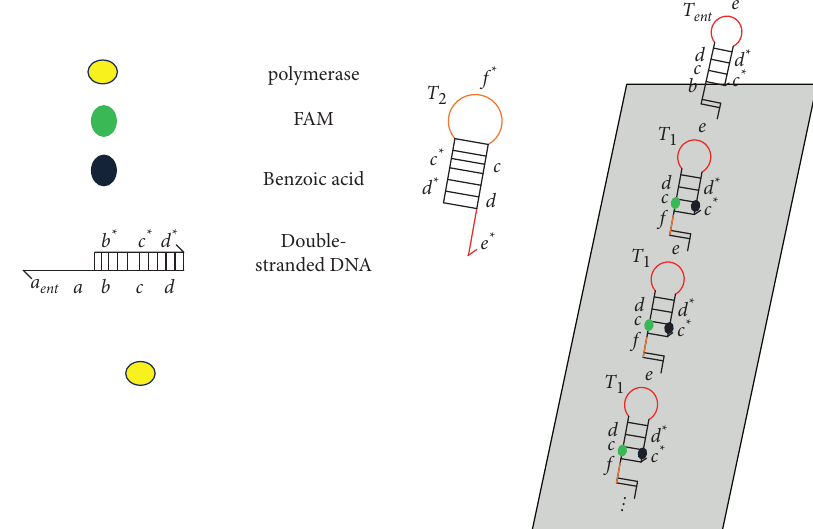
Figure 7: The case of AND gate input (0, 1).